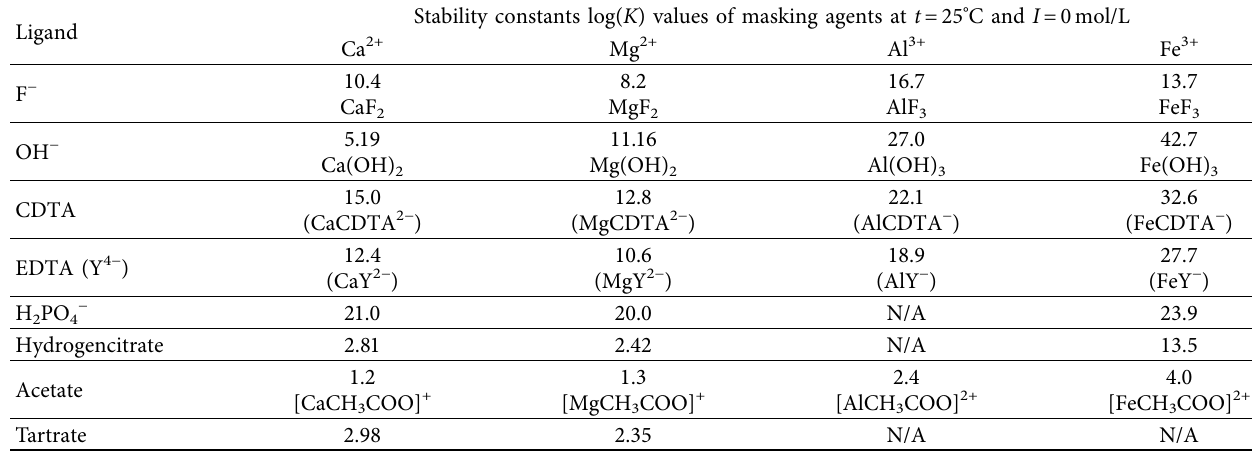
Table 3: Stability constants log ( K ) values of masking agents for different ligands adapted from [48, 49].